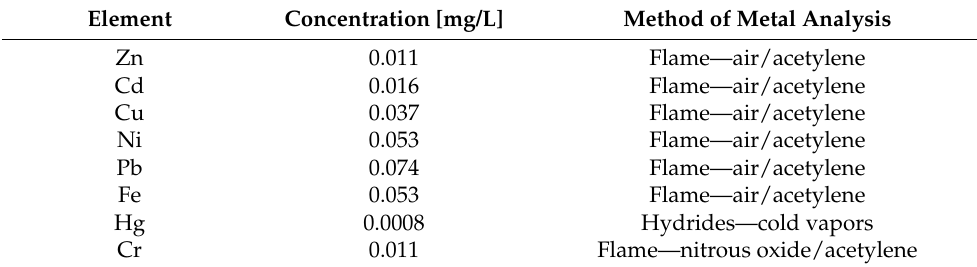
Table 1. Metals’ leaching concentrations from the spent garnet.